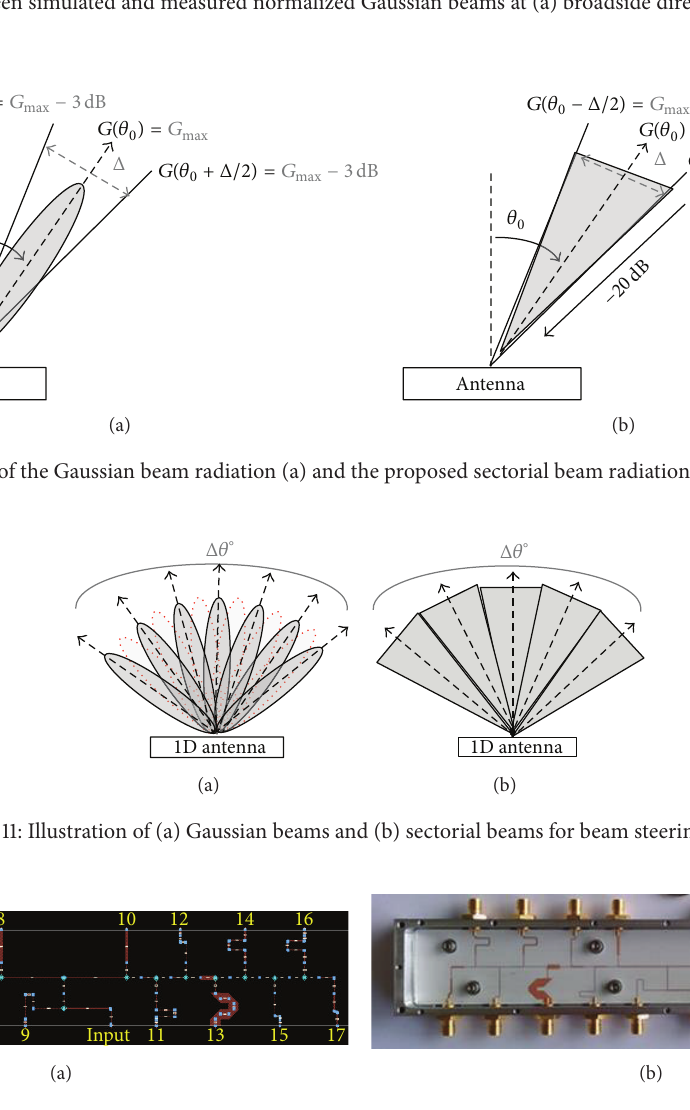
Figure 12: Cardinal sine power divider: (a) momentum layout and (b) manufactured